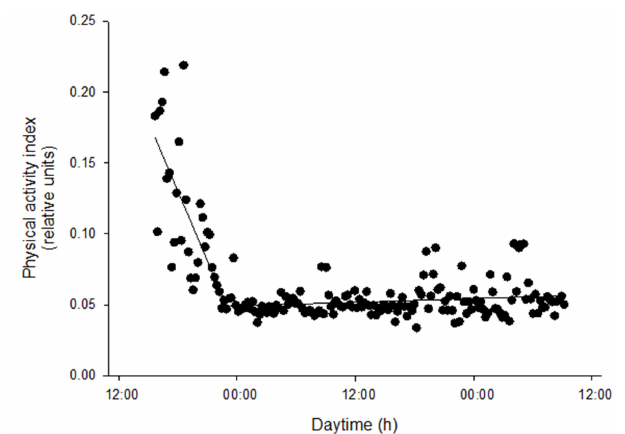
Figure 2. AEFishBIT records of physical activity of a representative individual after tagging and return to the tank. Measures (black circles) were taken along two consecutive days every 15 min. Lines represent piecewise linear fit of data with one break point.